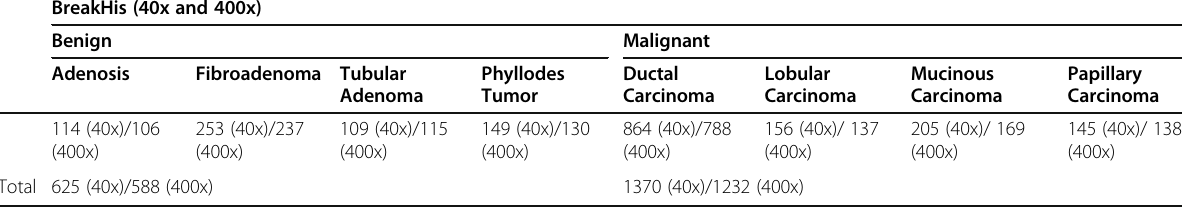
Table 1 Summarized composition of the number of images on the BreakHis set BreakHis (40x and 400x)